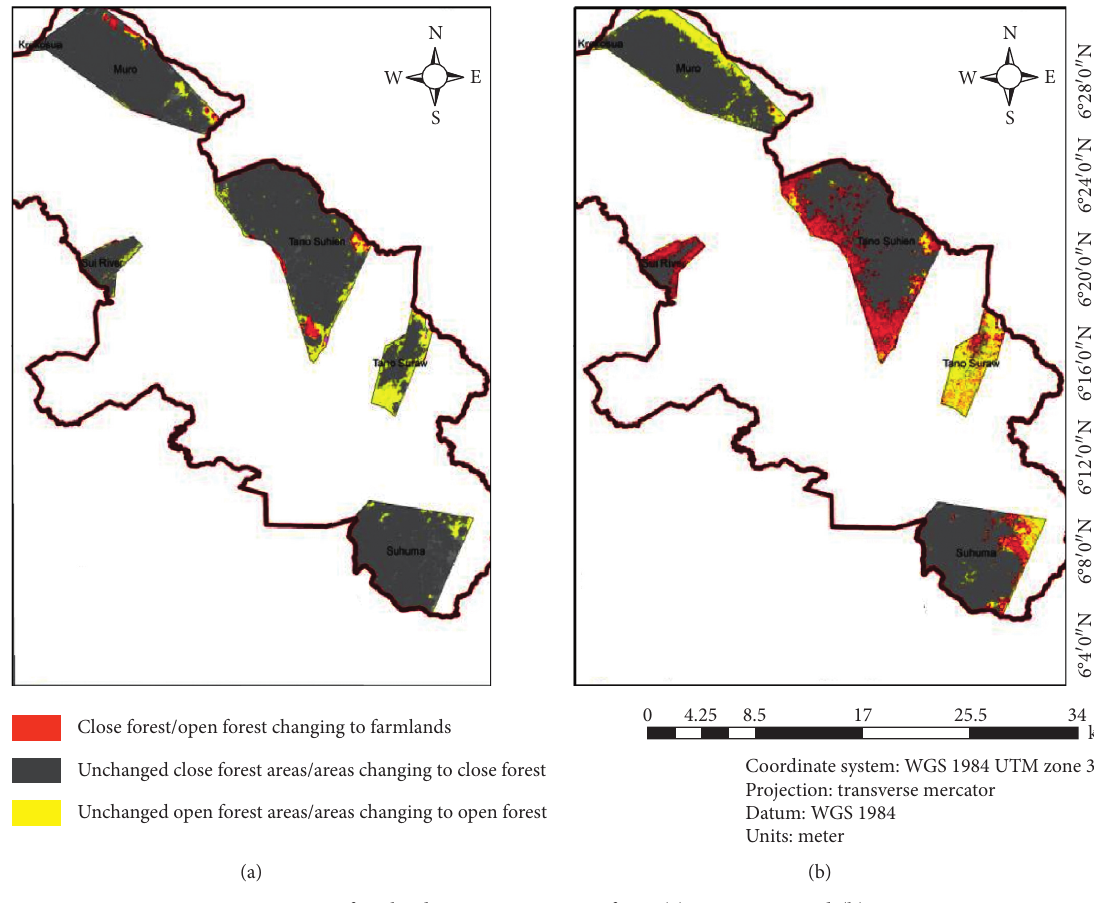
Figure 11: Forest to farmland cover conversions from (a) 2000–2010 and (b)